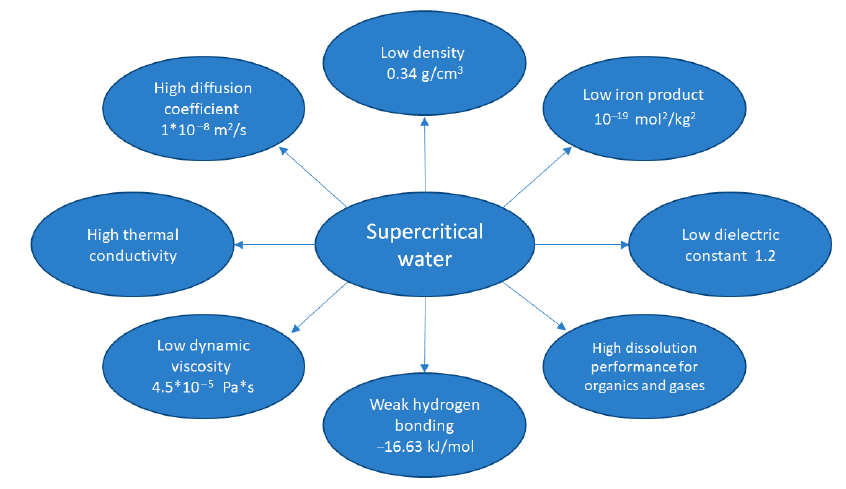
Fig. 5. Characteristics of supercritical water (SW) [59,